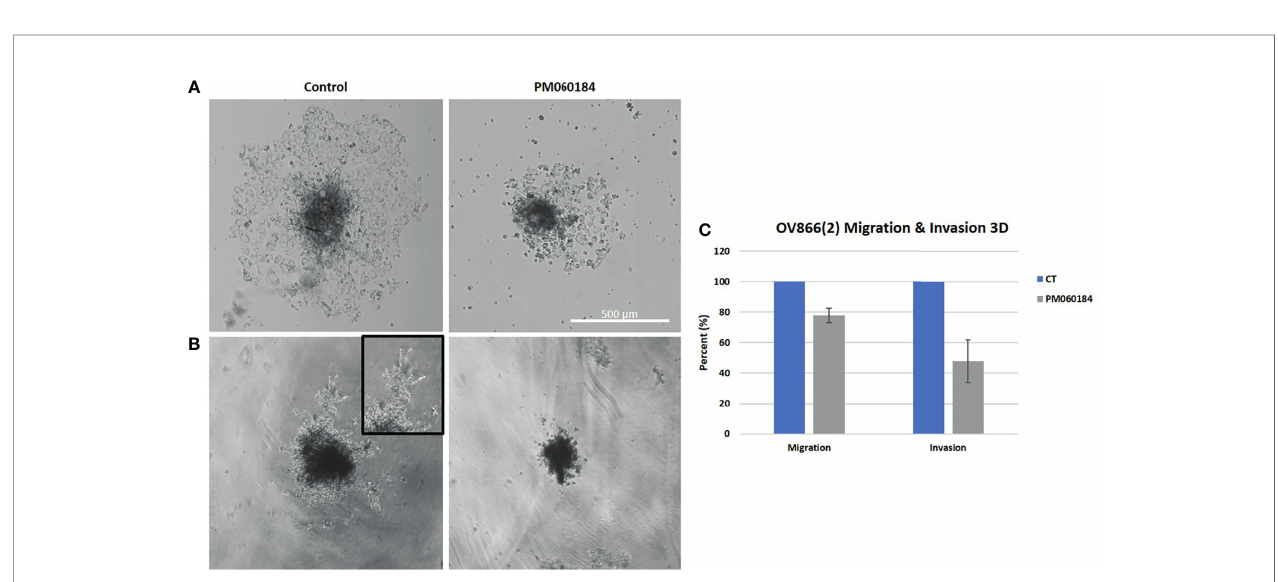
FIGURE 3 | Plocabulin effect on OV866(2) spheroids migration (A) and invasion (B) . Pictures are of a representative experiment. (C) Bar plots represent the quanti fi cation of the data calculated with the mean values of at least two experiments. CT: untreated control.